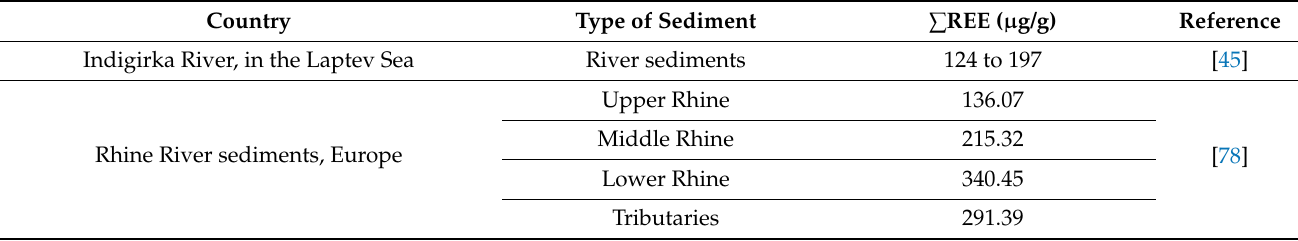
Table 3. REE concentrations in stream sediments, river sediments, and lake sediments in different parts of the